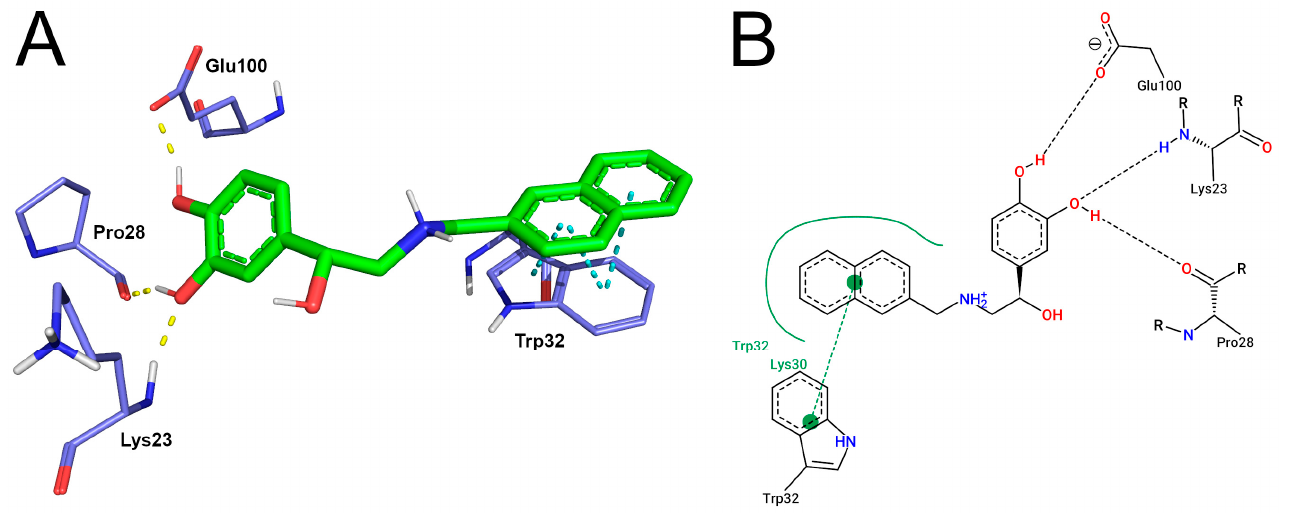
Figure 1. SOD1-SBL-1 binding mode observed in the crystallographic structure 5YTO. ( A ) Three-dimensional representations of SOD1-SBL-1 interactions were designed using the Pymol software. The SBL-1 molecule is represented by green sticks and colored by atom type. The interacting residues of SOD1 are represented by purple lines, colored by atom type, and labeled with the corresponding amino acid residue. Hydrogen bonds are represented by dashed yellow lines, while π -stacking is represented by dashed cyan lines. Residues involved in hydrophobic contact with SBL-1 are also shown. ( B ) Bidimensional diagram of SOD1-SBL-1 interactions designed using the PoseView software. SBL-1 and interacting residues of SOD1 (labeled) are represented by black lines and colored by atom type. Hydrogen bond interactions are represented by dashed black lines, and hydrophobic contacts are represented by continuous green lines.